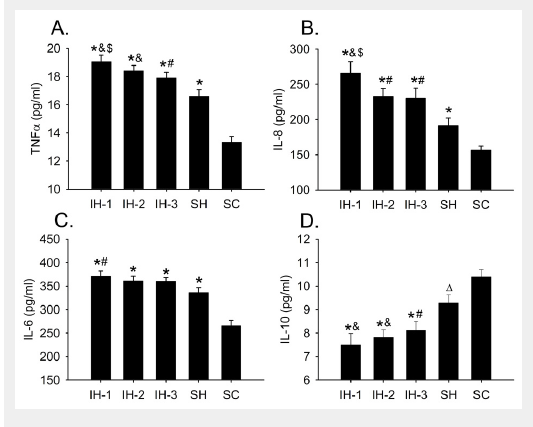
Comparison of serum levels of inflammatory cytokines at the 6 th week under intermittent hypoxia. Serum levels of TNF-α (A), IL-8 (B), IL-6 (C), and IL-10 (D) at the 6 th week of the hypoxic treatment were re-plotted as bar graphs for comparison among different groups. * p = 0.01 compared with SC group; ∆ p = 0.05 compared with SC group; # p = 0.05 compared with SH group; & p = 0.01 compared with SH group; & p = 0.05 compared with IH-3 group, n = 7 or 8 in each